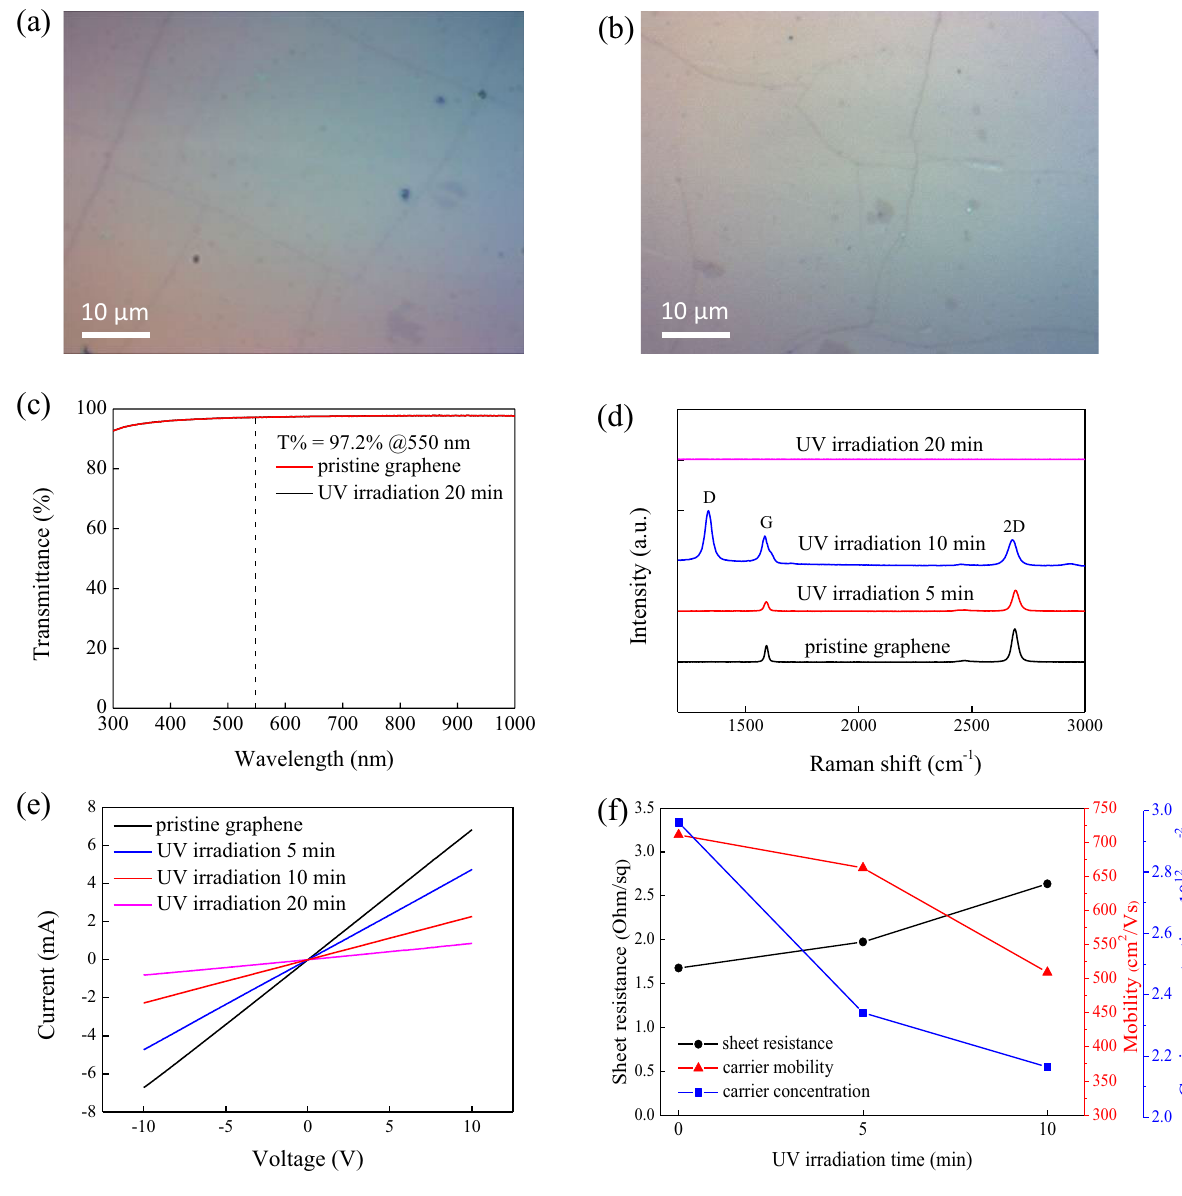
Figure 1. Before ( a ) and after ( b ) graphene UV irradiation OM diagram at 100 ×, scale bar: 10 μm. (c ) Transmittance spectrum of graphene without and with UV irradiation for 20 min. ( d ) Graphene Raman spectra showing unmodified and UV ozone irradiation time of 5, 10, 20 min. ( e ) IV curves of graphene for unmodified and UV irradiation at 5, 10, 20 min, respectively. ( f ) Sheet resistance, carrier mobility, and carrier concentration of graphene for unmodified and UV irradiation at 5, 10, 20 min,